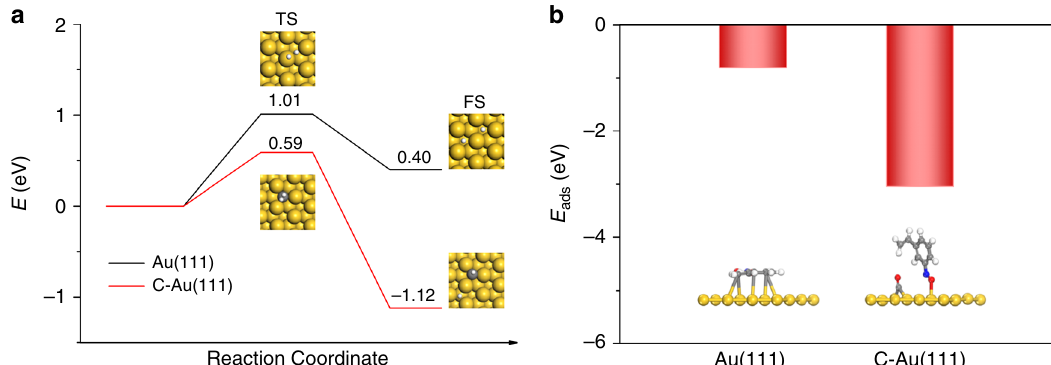
Fig. 4 DFT calculations. a Energy pro fi les for the dissociation of H 2 at Au surfaces. The black line belongs to heterolytic dissociation on clean Au(111), and the red one to heterolytic dissociation on C-modi fi ed Au(111). The zero-point energy correction is included in the pro fi le. b Adsorption modes of 3-NS and its corresponding energies on clean Au(111) and C-modi fi ed